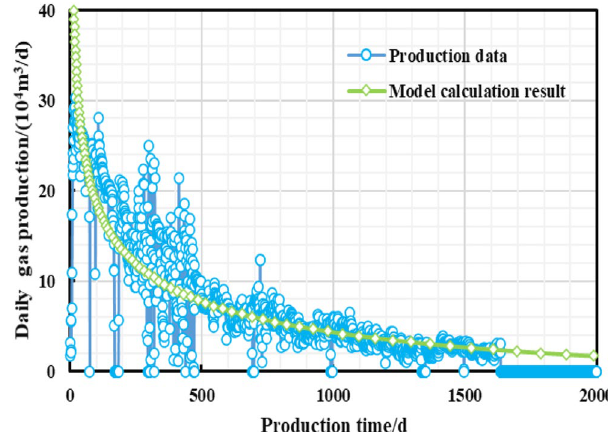
Figure 18. Production effect fitting of HD well.